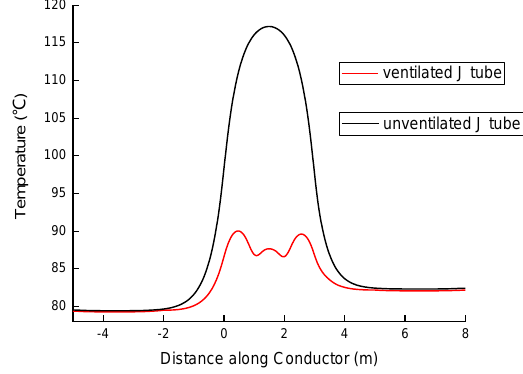
Figure 8. Conductor temperature profiles when the wind speed is 10 m/s.